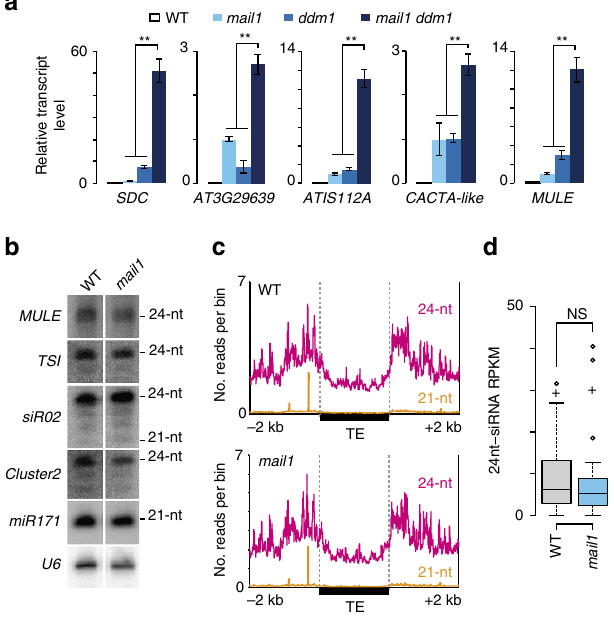
Figure 4 | Loss of silencing in mail1 is independent of DNA methylation and siRNA accumulation. ( a ) Expression analysis of mail1 -overexpressed loci by quantitative RT–PCR in the indicated genotypes. mail1 levels are set to 1; values represent means from two to three biological replicates ± s.e.m. Asterisks mark statistically significant differences from the mail1 ddm1 double mutant (unpaired, two-sided Student’s t- test, P o 0.05). ( b ) RNA gel blot analysis of siRNA accumulation. U6 RNA is shown as loading control. ( c ) 21- and 24-nt siRNA levels at TEs are unaltered in mail1 . Number of uniquely mapped 21- and 24-nt siRNAs plotted along all Arabidopsis thaliana TEs from 2kb upstream to 2kb downstream of the TE annotation. Upstream and downstream sequences were divided each into 2,000 one-nucleotide bins, and TEs were divided into 2,000 bins of equal length. Average siRNA levels were computed for each bin in WTand mail1 . ( d ) Boxplot of 24-nt siRNA accumulation level at mail1 -upregulated TEs. Each box encloses the middle 50% of the distribution with the center lines marking the medians. Crosses mark sample means. Whiskers extend 1.5 times the interquartile range from the 25th and 75th percentiles. Outliers are represented by circles.